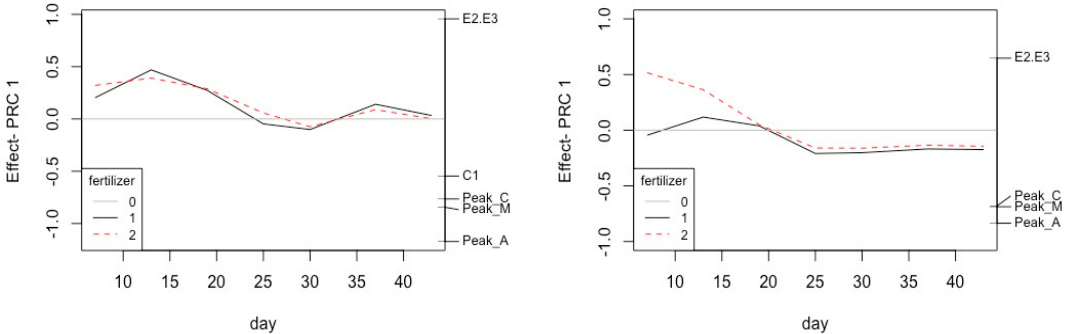
Figure 3. The first component of the principal response curves (PRC) of the silt loam ( left ) and sandy loam ( right ) DOM dataset are shown, using the control soil core as an internal reference (indicated by 0; grey line). The species weights shown in the right part of each PCR. Secondary axis shows the affinity of each indices with the response shown in each figure. For the sake of clarity, only species with a species weight larger than +0.5 or smaller than –0.5 are shown. The effect of DOM to fertilization is indicated by the resulting response curves (1 (black line) = organic; 2 (red dashed line) = mineral).